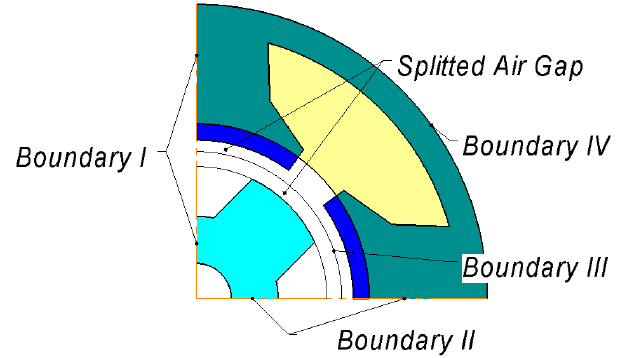
Figure 4. Calculation area scheme.